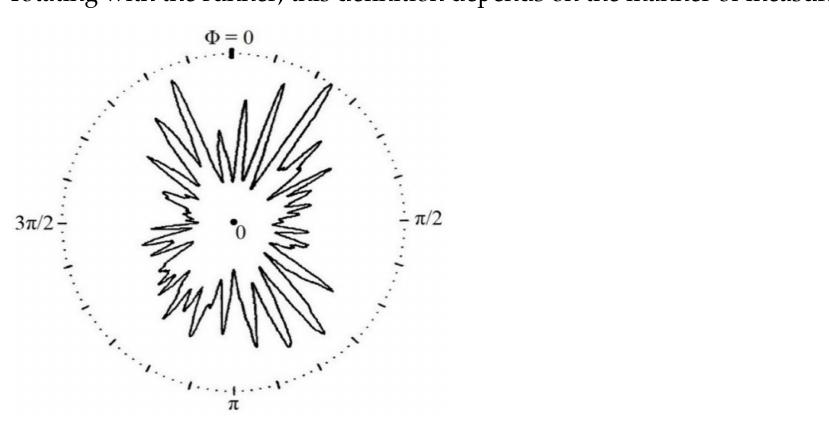
Figure 3. Front panel of the multidimensional data acquisition processor. The simplest description of cavitation comes out online after half an hour of measurement on the prototype. More compli- cated descriptions require days or weeks of recorded data analysis by a trained user.